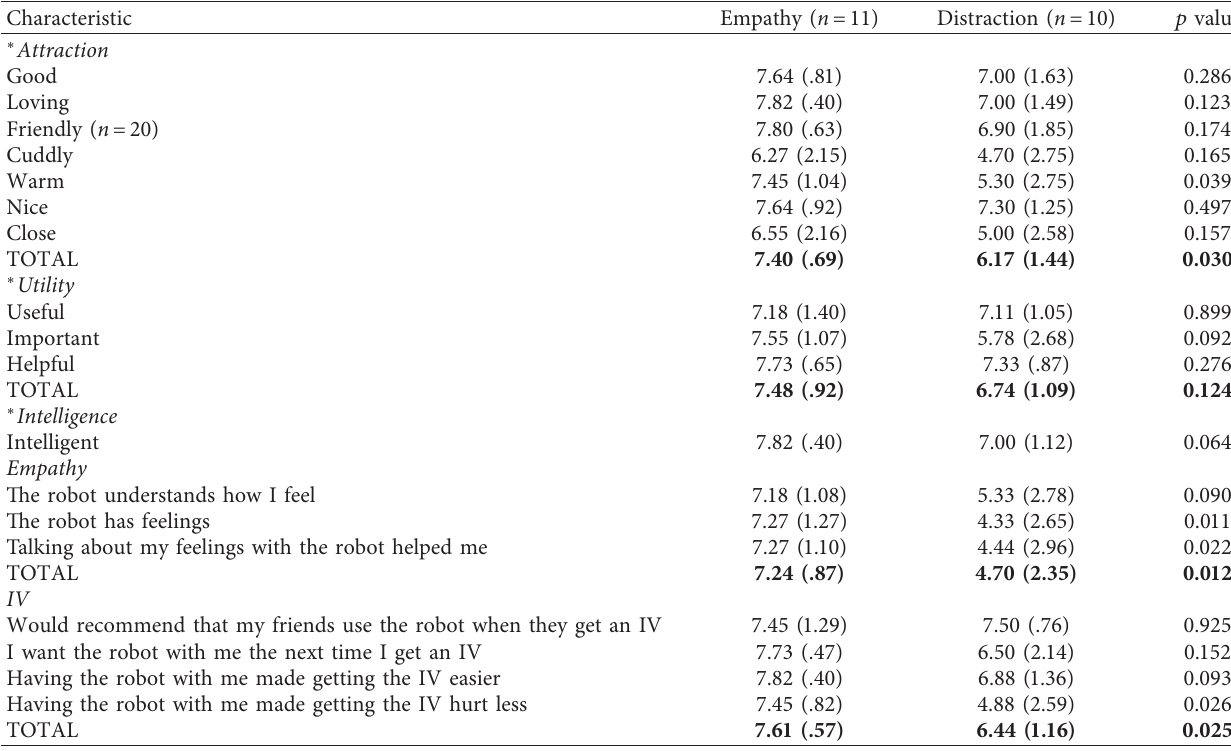
Table 3: Child impressions of